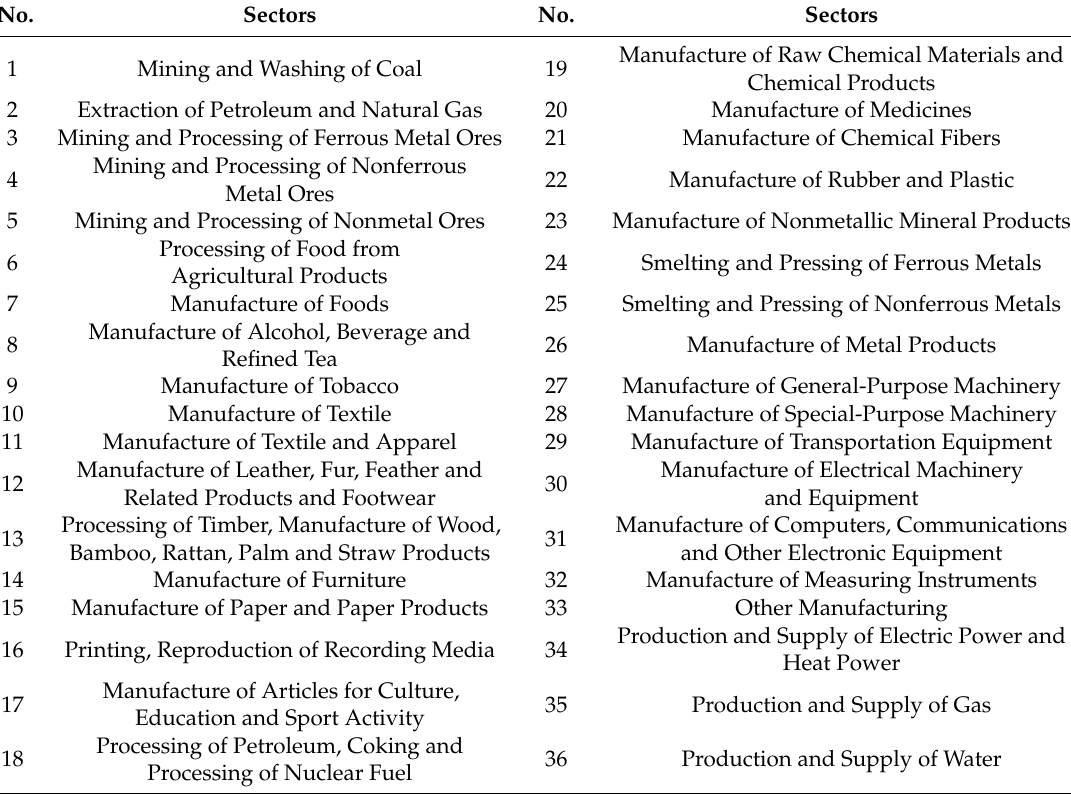
Table 1. Industrial sectors included in this study.